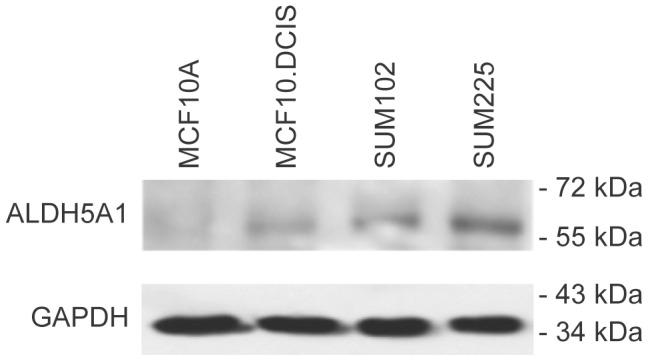
ALDH5A1 is over-expressed in DCIS models.Whole cell lysates from 3D rBM overlay cultures of MCF10A, MCF10.DCIS, SUM102 and SUM225 were probed for ALDH5A1 (upper panel) and for GAPDH (lower panel) as a loading control. Densitometry indicated that ALDH5A1 levels in the lysates of MCF10.DCIS, SUM102, and SUM225 were 2.7, 3.1, and 7.3-fold over that in MCF10A in this representative experiment. In three independent analyses of MCF10.DCIS 3D rBM cultures, the mean increase in ALDH5A1 over control was 3.8-fold.